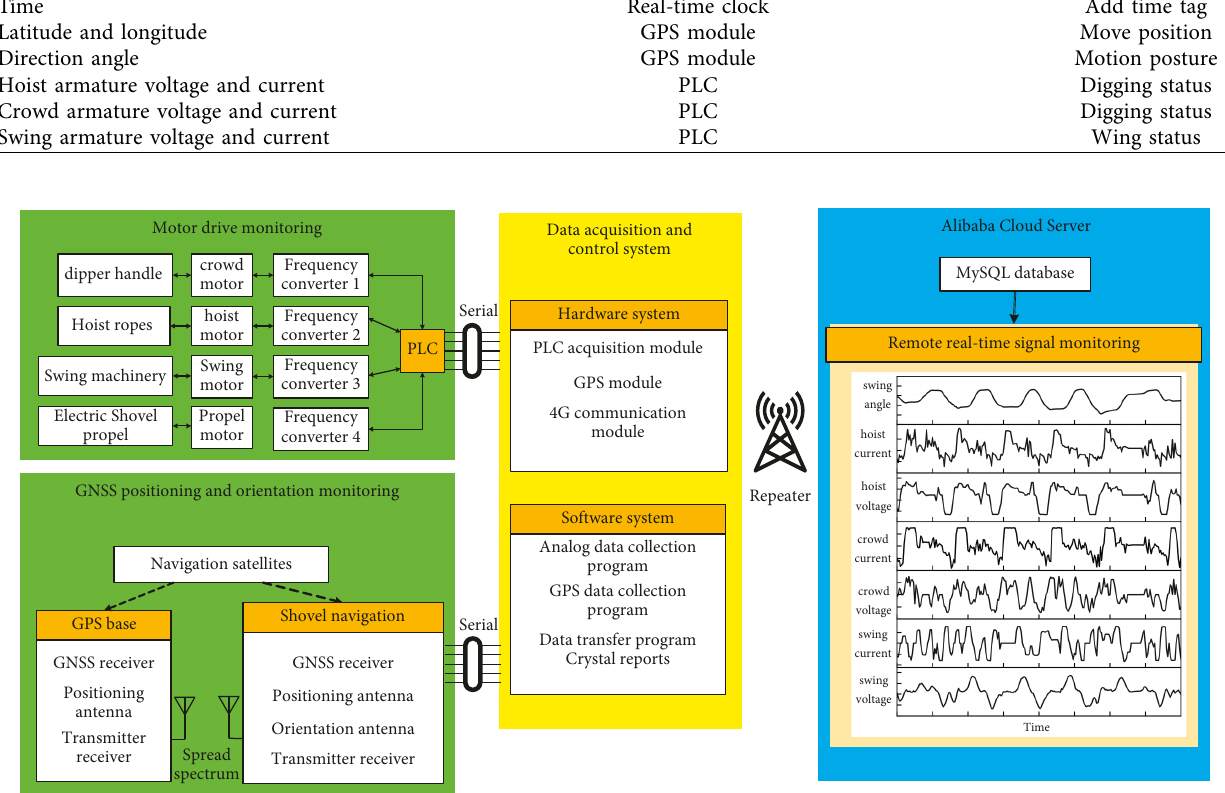
Figure 1: Data acquisition and remote monitoring system.